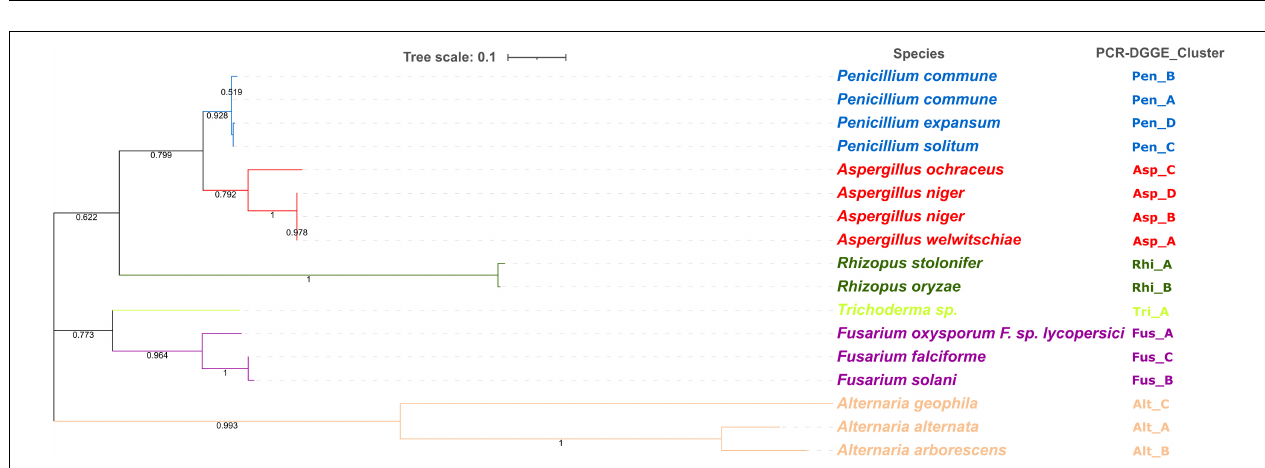
FIGURE 6 | Phylogenetic analysis of ITS region of 17 isolates ( Penicillium spp., N = 4; Aspergillus spp., N = 4; Rhizopus spp., N = 2; Trichoderma spp., N = 1; Fusarium spp., N = 3; Alternaria spp., N = 3). Phylogenetic tree calculation was performed with the Neighbor-Joining method and using MEGAX software. Statistical significance has been tested by using bootstrap